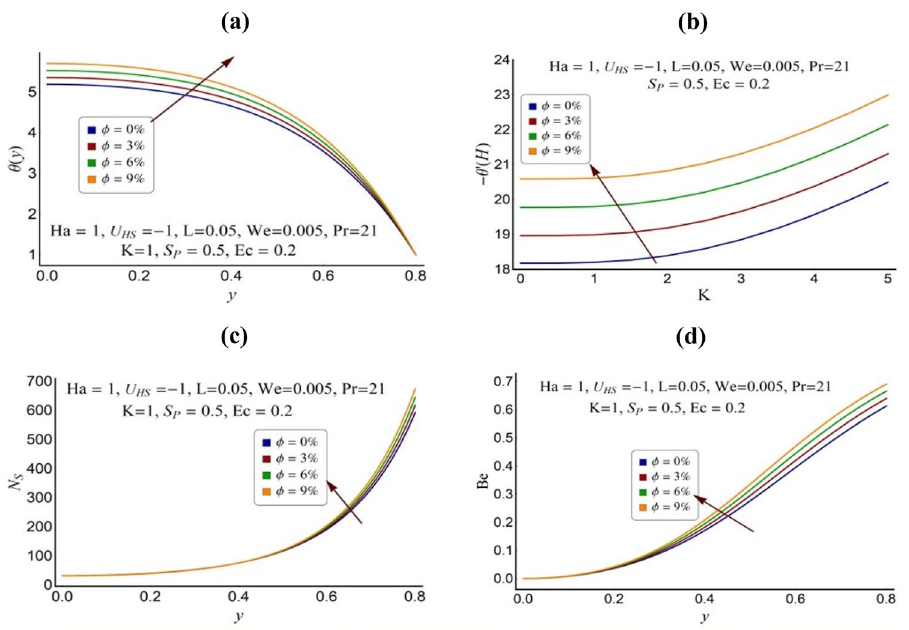
Figure 9. Effect of nanoparticles volume fraction ( a ) on the temperature profile ( b ) on the heat transfer rate ( c ) on the total entropy number and ( d ) on the Bejan